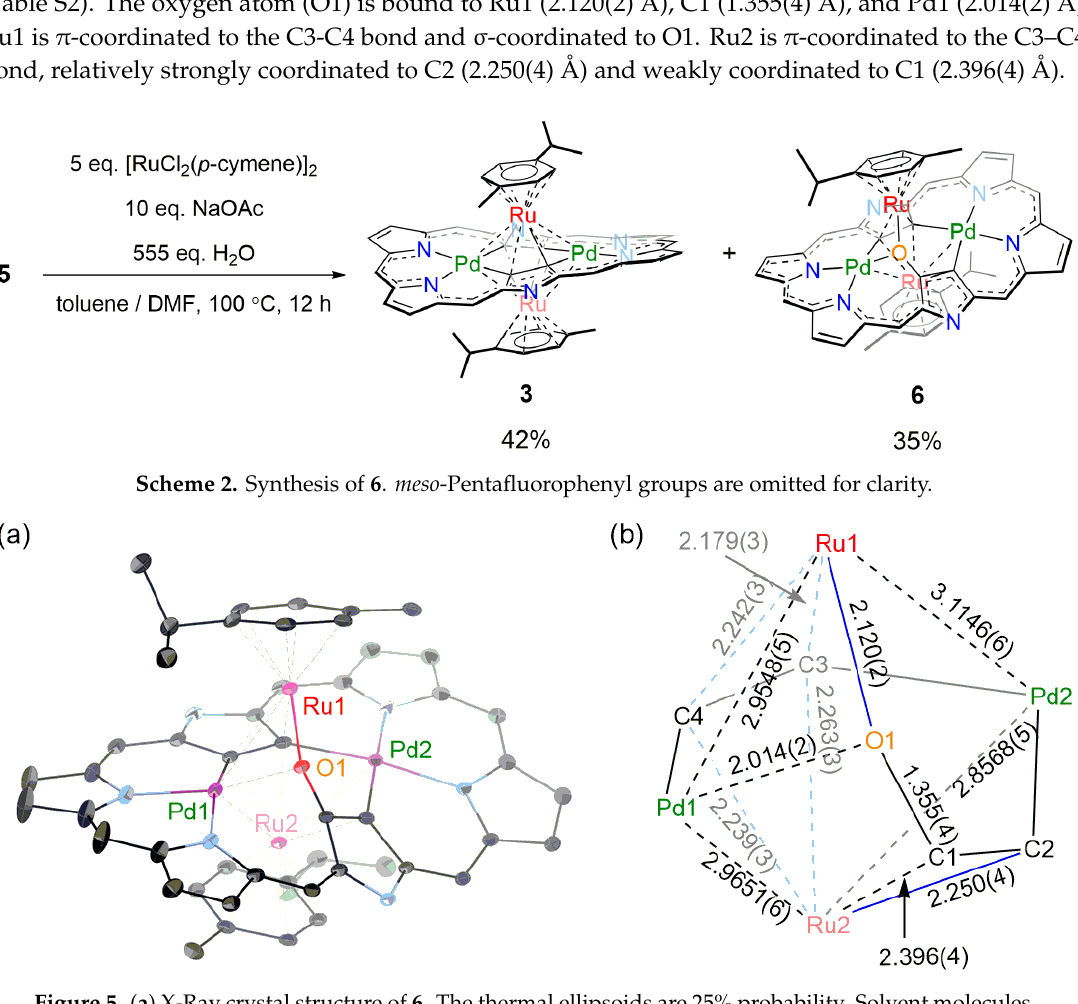
Figure 5. ( a ) X-Ray crystal structure of 6 . The thermal ellipsoids are 25% probability. Solvent molecules, pentafluorophenyl groups, and hydrogen atoms are omitted for clarity. ( b ) Detailed bond lengths of 6 . Bond lengths are shown in Å.